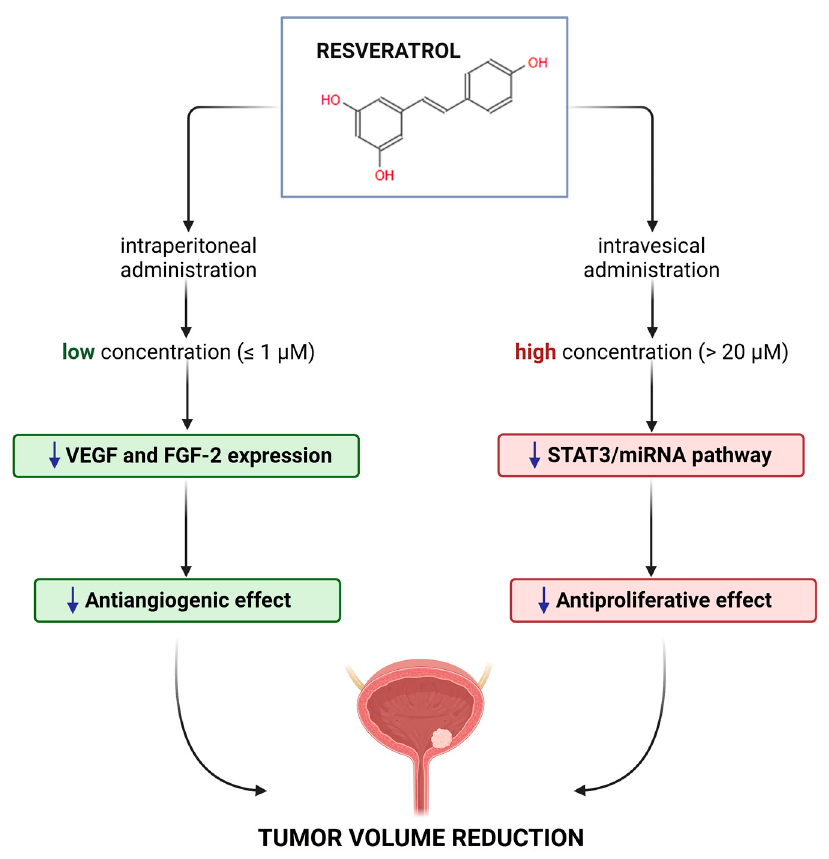
Figure 2. Effects of resveratrol on bladder cancer in in vivo models. At low concentrations (achievable through an intraperitoneal administration, i.p., lower or equal to about 1 µ M [40]), resveratrol exhibits an antiangiogenic effect, reducing vascular endothelial growth factor (VEGF) and fibroblast growth factor 2 (FGF-2). On the other hand, at high concentrations (achievable through an intravesical administration, i.v., higher than 200 µ M [44]), it shows an antiproliferative effect, reducing miRNA21, the signal transducer and activator of transcription 3 (STAT3) and its downstream genes. Created with BioRender.com.